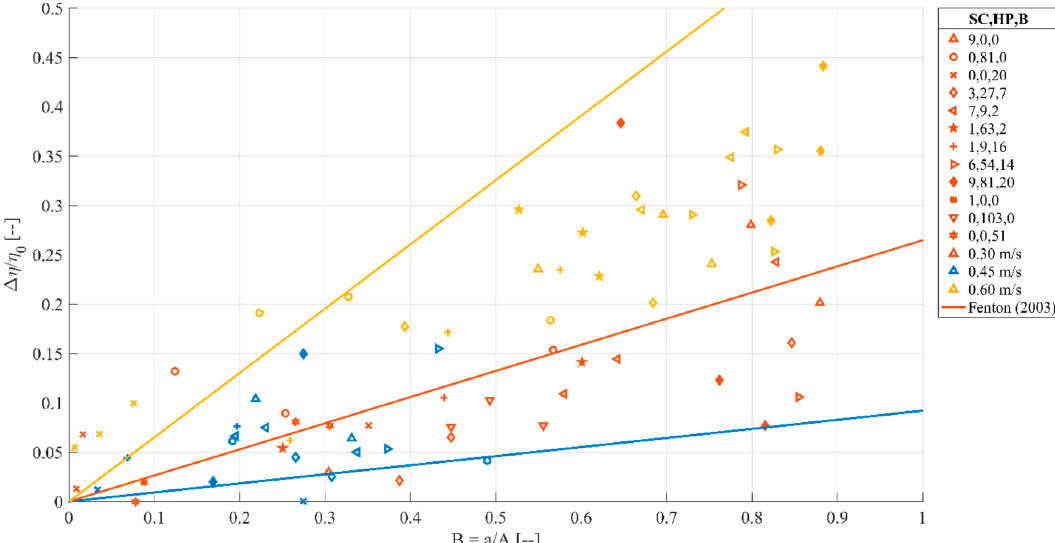
Figure 14. Backwater rise as a function of the blockage ratio. The backwater rise is compared to the analytical solution from Fenton (2003). The different debris configurations are displayed by differing symbols, the hydrodynamic conditions are displayed by color.